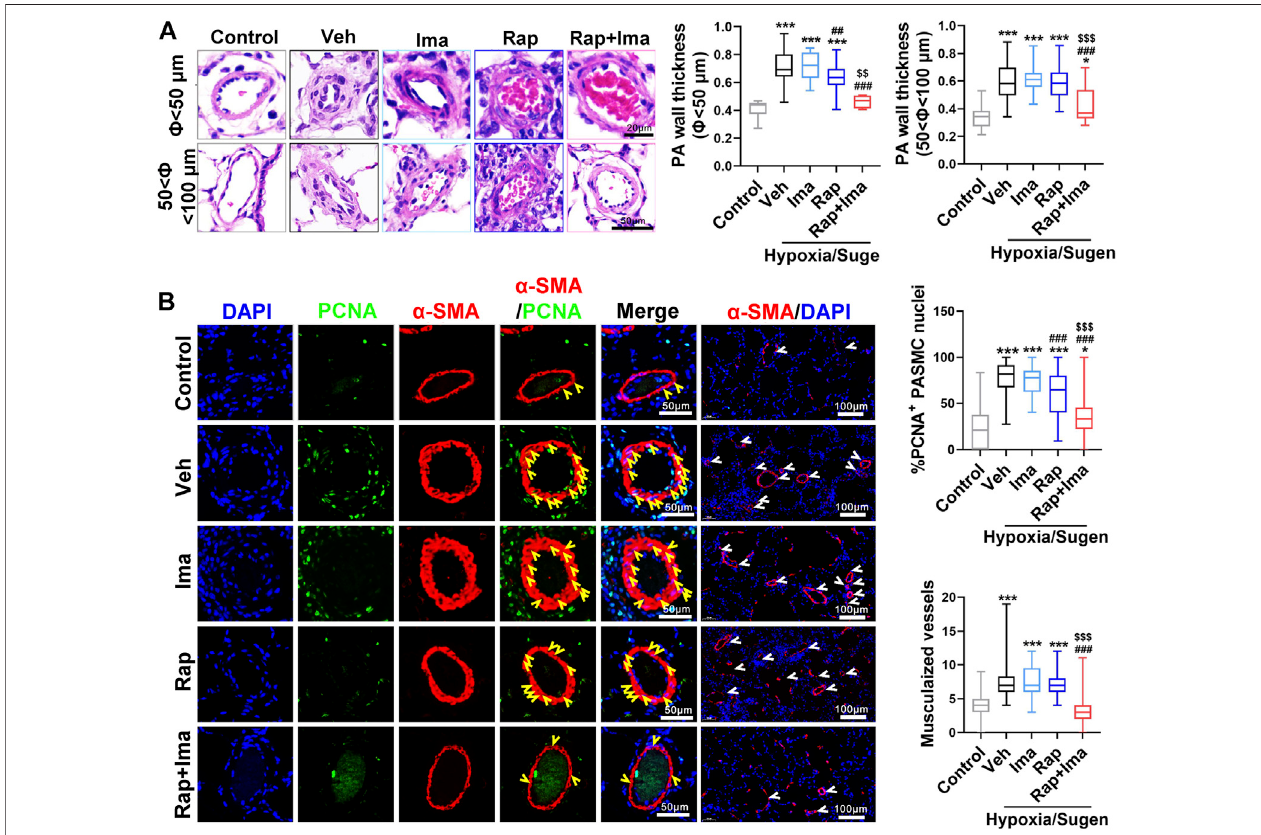
FIGURE 7 | Rapamycin combined with imatinib attenuates PASMC proliferation and remodeling induced by Hypoxia/Sugen. (A) H&E staining of lung tissue sections and summarized datashowingpulmonaryartery mediawall thickness. (B) Lung sections werestained with α -SMA(red) and PCNA (green). Yellow arrowheads point at PCNA positive PASMCs and white arrowheads show the vessels. For each of the 5 groups, approximately 600 PASMC nuclei and 100 fi elds were analyzed. Summarized data showing PCNA positive cells and muscularization. Data are presented as the mean ± SE. One-way ANOVA was used for statistical analysis. NS meansnosigni fi cant.*** p < 0.001,** p < 0.01,* p < 0.05versuscontrol; ### p < 0.001, ## p < 0.01, # p < 0.05versusHypoxia/Sugenwithvehicle; $$$ p < 0.001, $$ p < 0.01, $ p < 0.05 versus Hypoxia/Sugen with